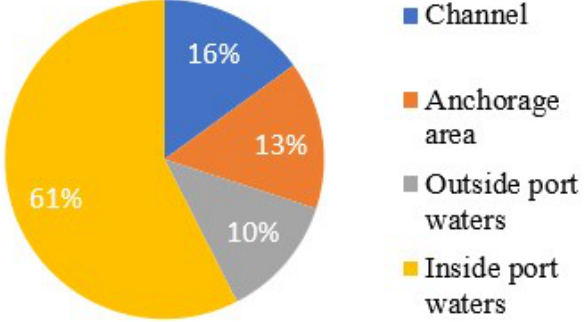
Figure 10. The locations of marine